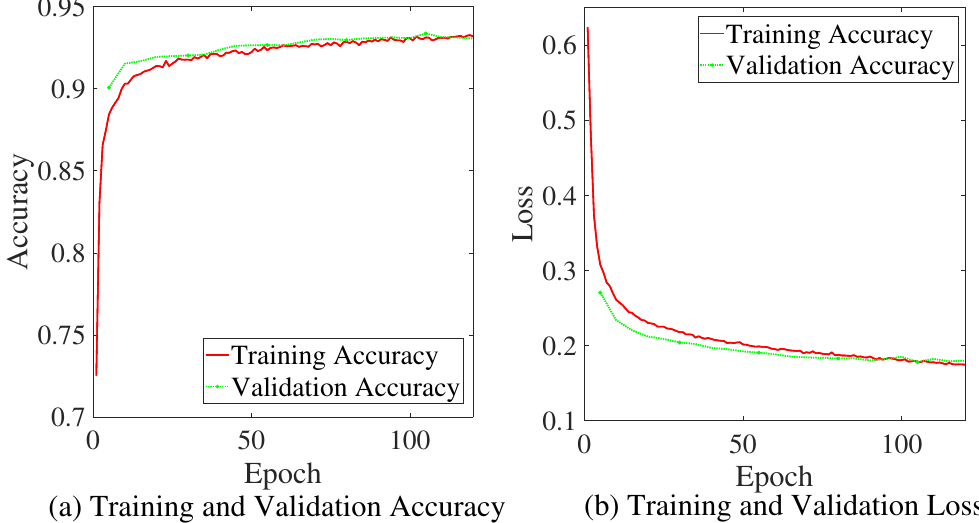
Figure 5. The accuracy and loss of the PPM